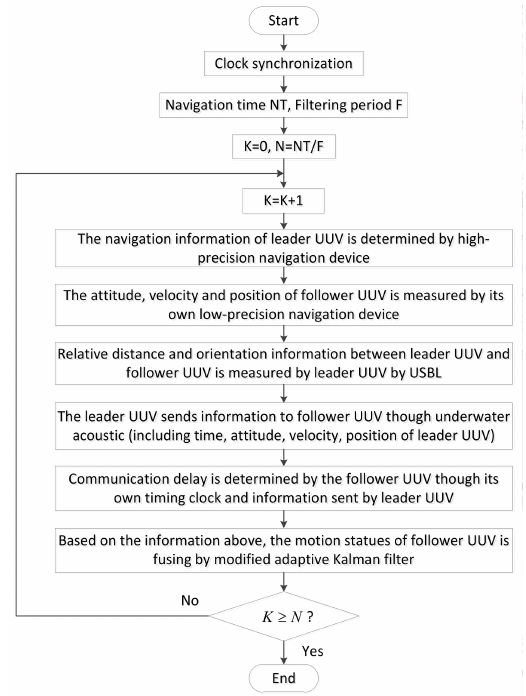
Figure 3. Overall process of the polar cooperative navigation